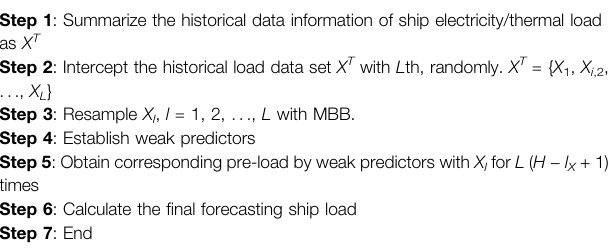
TABLE 1 | Ship load forecasting algorithm. Process of ship electricity/thermal-load